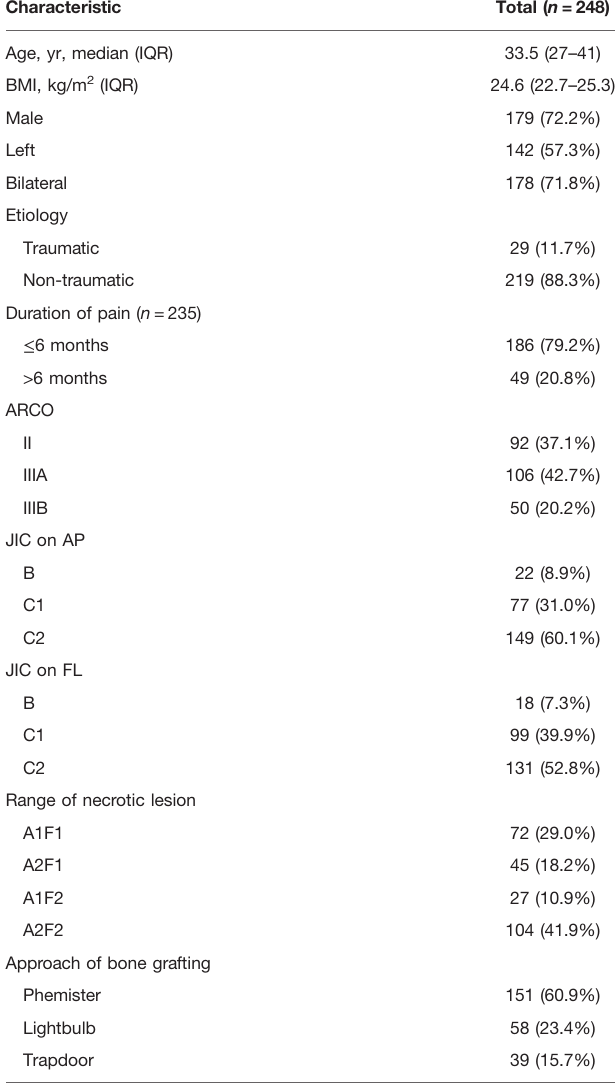
TABLE 2 | Baseline characteristics of the hips undergoing non-vascularized bone